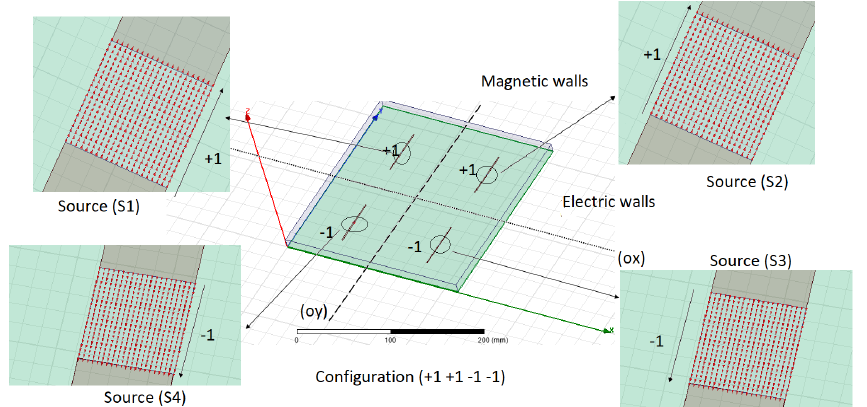
Figure 3. Example of a four symmetric antennas configuration with amplitudes of 11 − 1 − 1 (under HFSS): (ox) electrical walls, (oy) magnetic